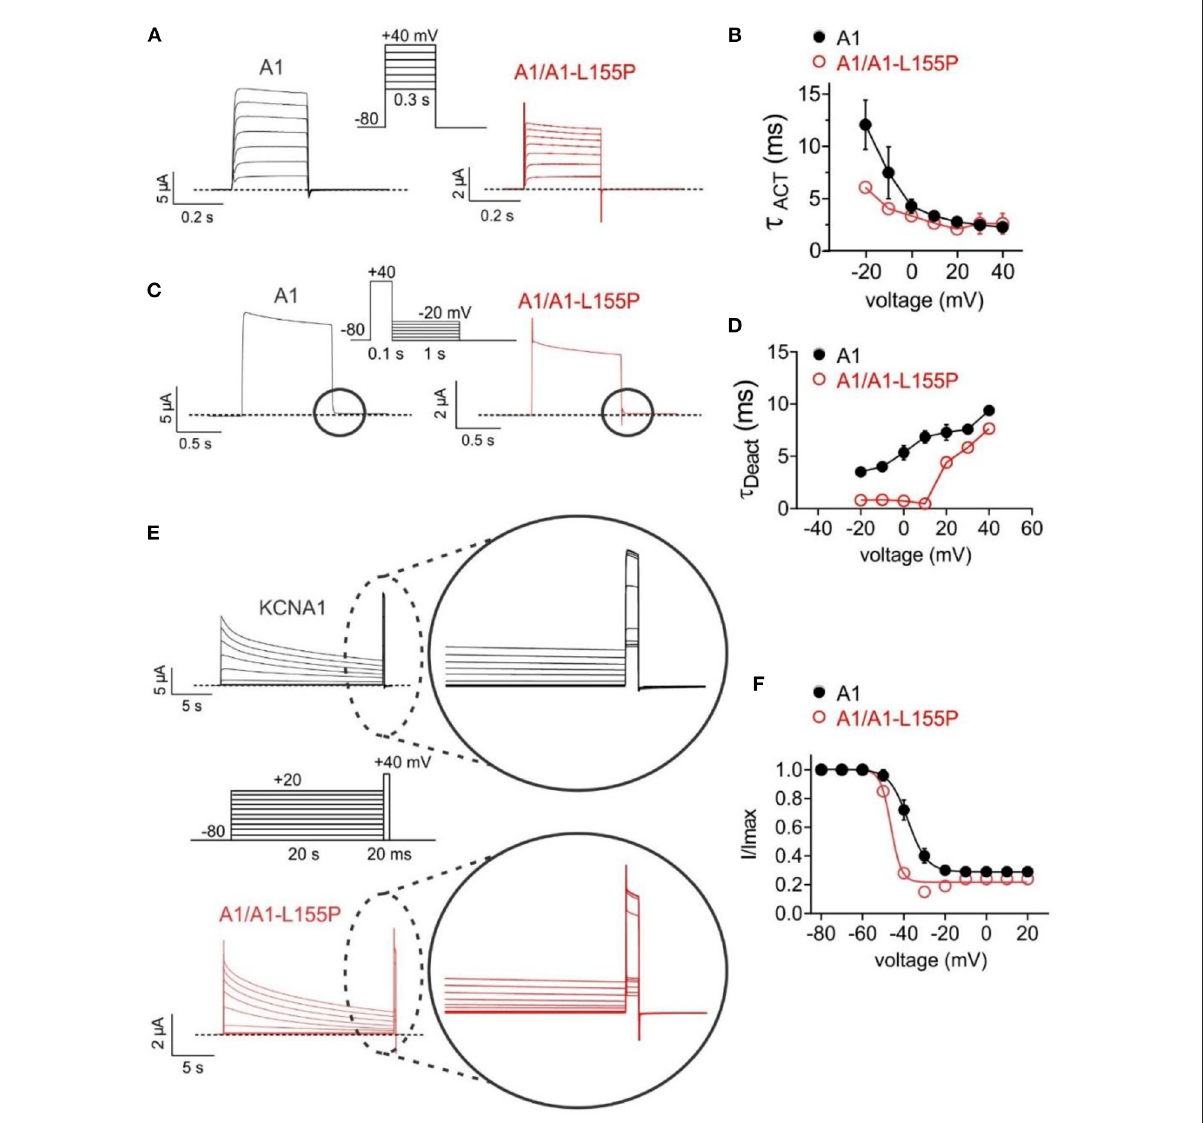
FIGURE3 Effects of L155P on KCNA1 gating. Error bars indicate SEM. n indicates number of oocytes. Dashed line indicates zero current level. (A) Mean traces for wild-type (A1) and heterozygous mutant (A1/A1-L155P) channels expressed in oocytes using the voltage protocol shown (upper inset). Scale bars lower left inset; n = 12–16 per group. (B) Mean activation rate (T ACT ) calculated using a single exponential function from traces as in (A) ; n = 12–16 per group. (C) Mean traces for wild-type (A1) and heterozygous mutant (A1/A1-L155P) channels expressed in oocytes using the voltage protocol shown (upper inset). Scale bars lower left inset; n = 12–16 per group. (D) Mean deactivation rate (T Deact ) calculated using a single exponential function from the circled portion of traces as in (C) ; n = 12–16 per group. (E) Mean traces for wild-type (A1) and heterozygous mutant (A1/A1-L155P) channels expressed in oocytes using the voltage protocol shown (center inset). Scale bars lower left inset; n = 12–16 per group. (F) Mean proportion of remaining non-inactivated current calculated from the circled portion of traces as in (E) ; n = 12–16 per group (see Table 1 for